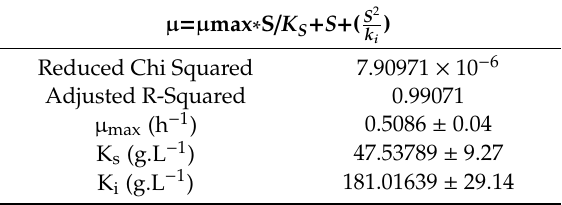
Table 2. The estimated kinetics parameters fitted to the Andrews model.